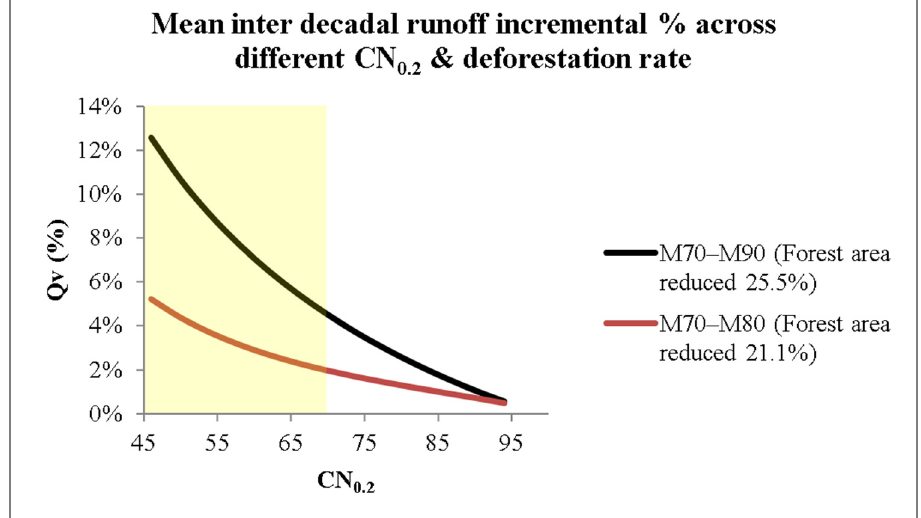
Figure 9. Mean inter-decadal runoff incremental % across different CN 0.2 classes (46 to 70) between 1970 (M70) and 2000 (M90). Note: The graph was created with decadal runoff models and Malaysia Department of Forestry data to coincide with the total forest area loss within the same period. On average, runoff volume for CN 0.2 classes ranging from 46 to 70 increased by 10.2% in Peninsular Malaysia while forest area reduced by 25.5% from 1970 to 2000.